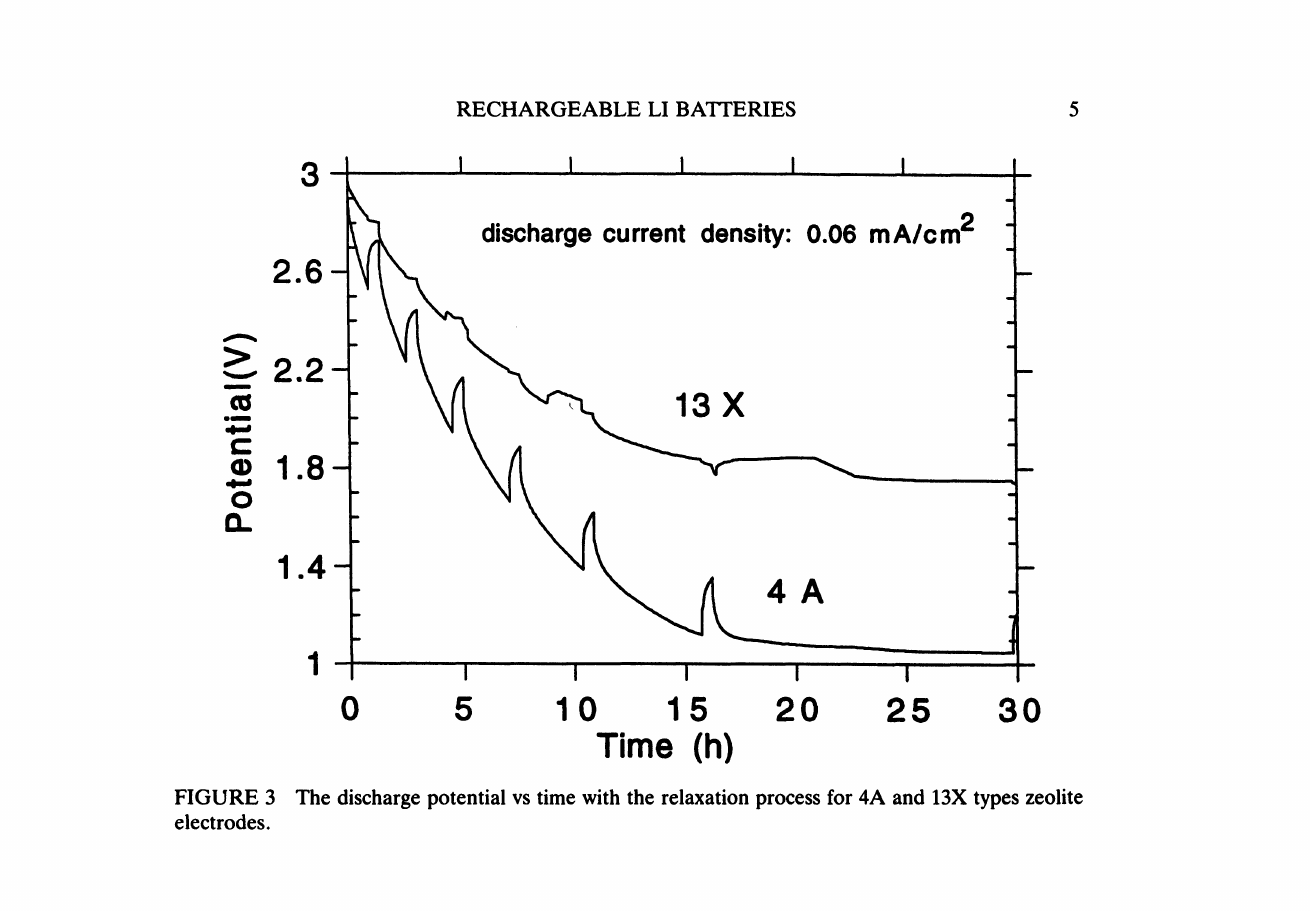
undertaken with two charge and discharge cycles and then have been discharged under 60/zA/cm 2 with relaxation times in order to obtain the thermodynamic